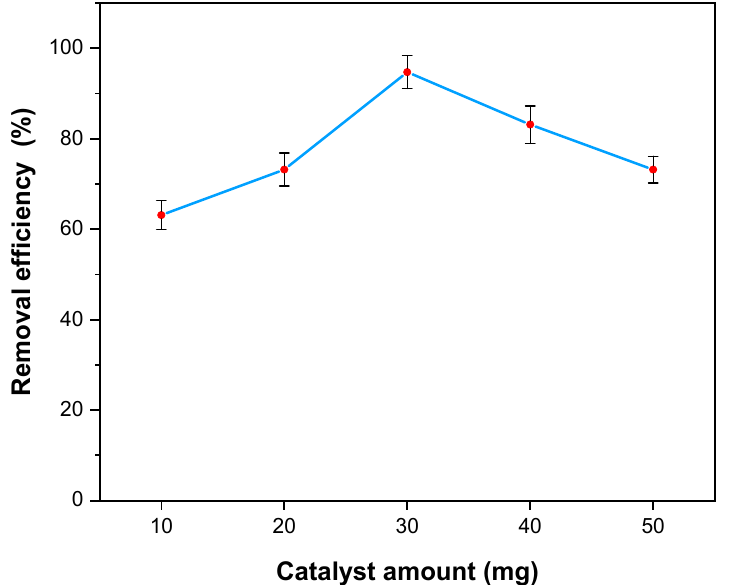
Figure 10. Effect of photocatalyst amount on the photocatalytic removal of MB with B–ZnO/TiO 2 (initial MB concentration: 15 mg/L; photocatalyst amount: 10 − 50 mg; pH: 11; irradiation time: 15 min).